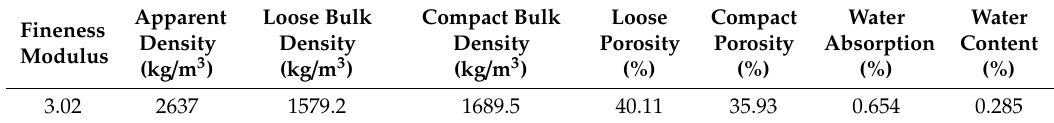
Table 4. The physical properties of sand.